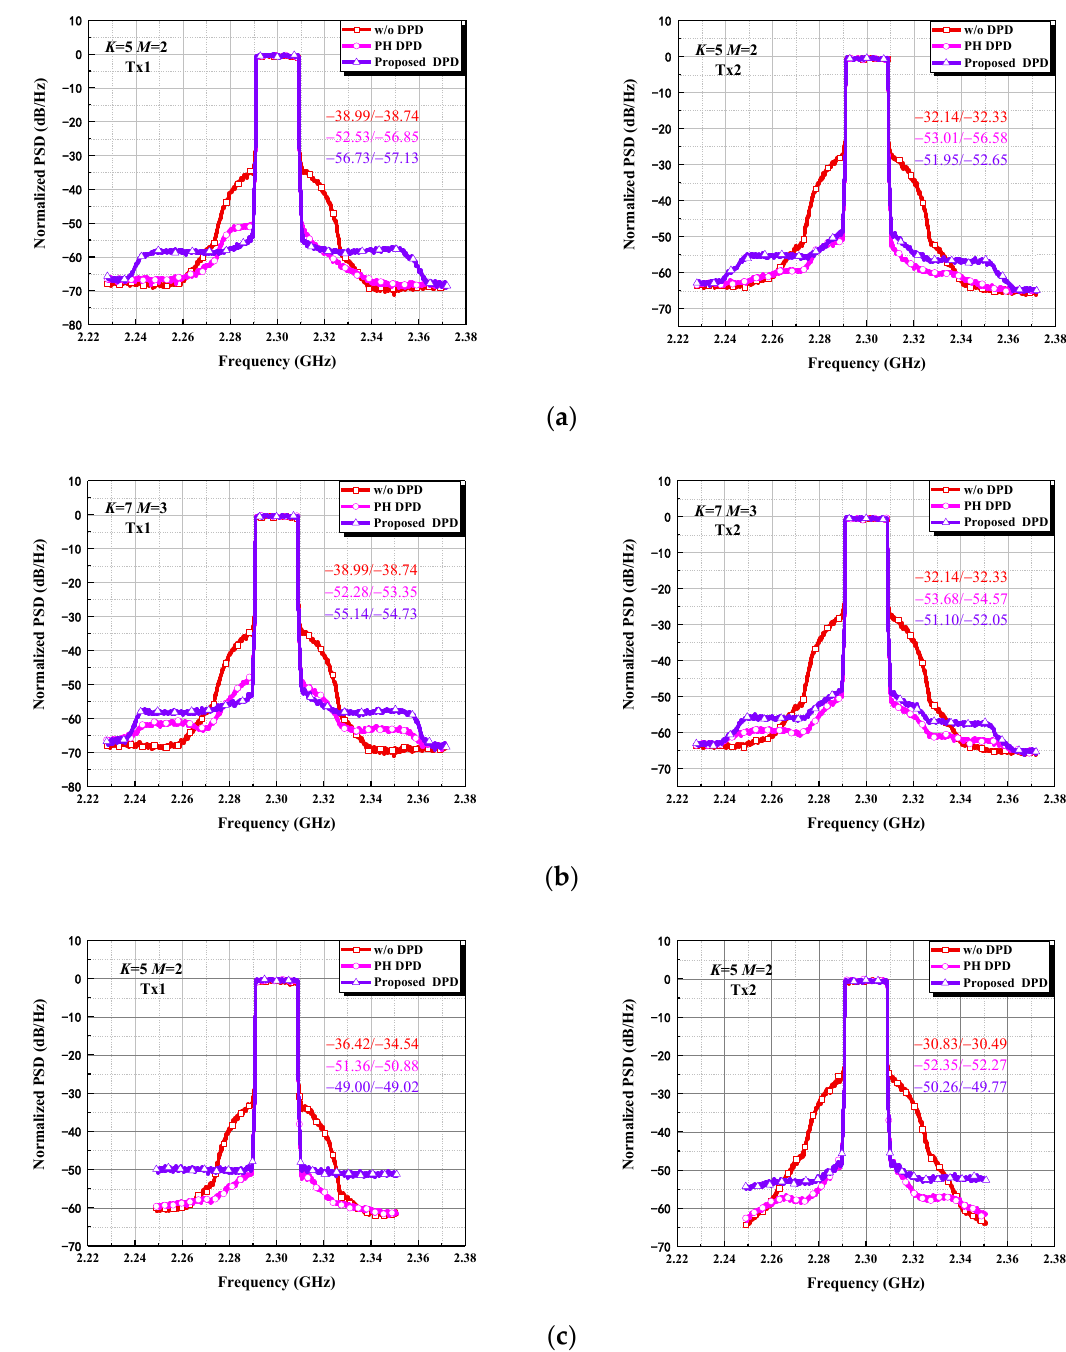
Figure 7. Normalized frequency power spectrum density (PSD) of different DPD models for ( a ) 20 MHz LTE signal for case 1, ( b ) 20 MHz LTE signal for case 2, ( c ) 20 MHz LTE signal for case 3.